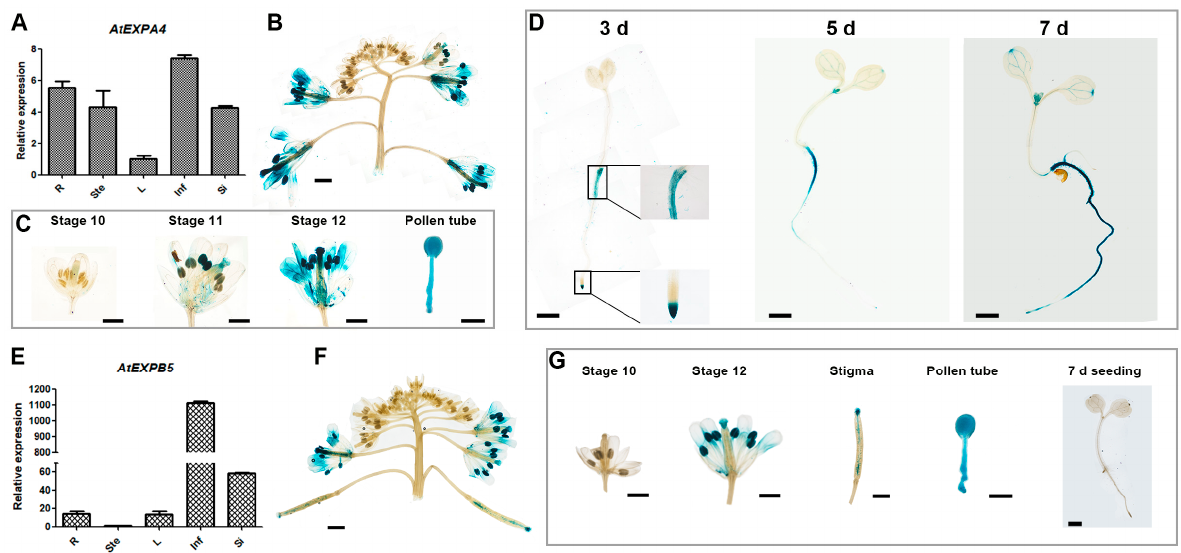
Figure 1. Expression pattern analysis of AtEXPA4 and AtEXPB5 . ( A , E ) qRT-PCR analysis of AtEXPA4 ( A ) and AtEXPB5 ( E ) transcripts in different tissues of Arabidopsis thaliana : 35-d-old roots (R), 35-d-old stems (Ste), young rosette leaves (L), 35-d-old inflorescences (Inf) and siliques (Si). BETA-TUBULIN4 was used as the reference gene. AtEXPA4 expression in leaf and AtEXPB5 expression in stem were normalized to 1. The values are the mean ± SD (standard deviation), three biological replicates with three technical replicates in each biological replicate. ( B – D ) Analysis of proAtEXPA4 :: GUS activity. ( B ) GUS activity in inflorescences. ( C ) GUS activity in different developmental stages of buds and pollen tubes. ( D ) GUS activity in seedlings at different time points after germination, days (d). ( F , G ) Analysis of proAtEXPB5 :: GUS activity. ( F ) GUS activity in inflorescences. ( G ) GUS activity in different developmental stages of buds, stigmas, pollen tubes, and 7-d-old seedlings. Scale bars of pollen tubes, 25 μ m. Scale bars of others, 1 mm.